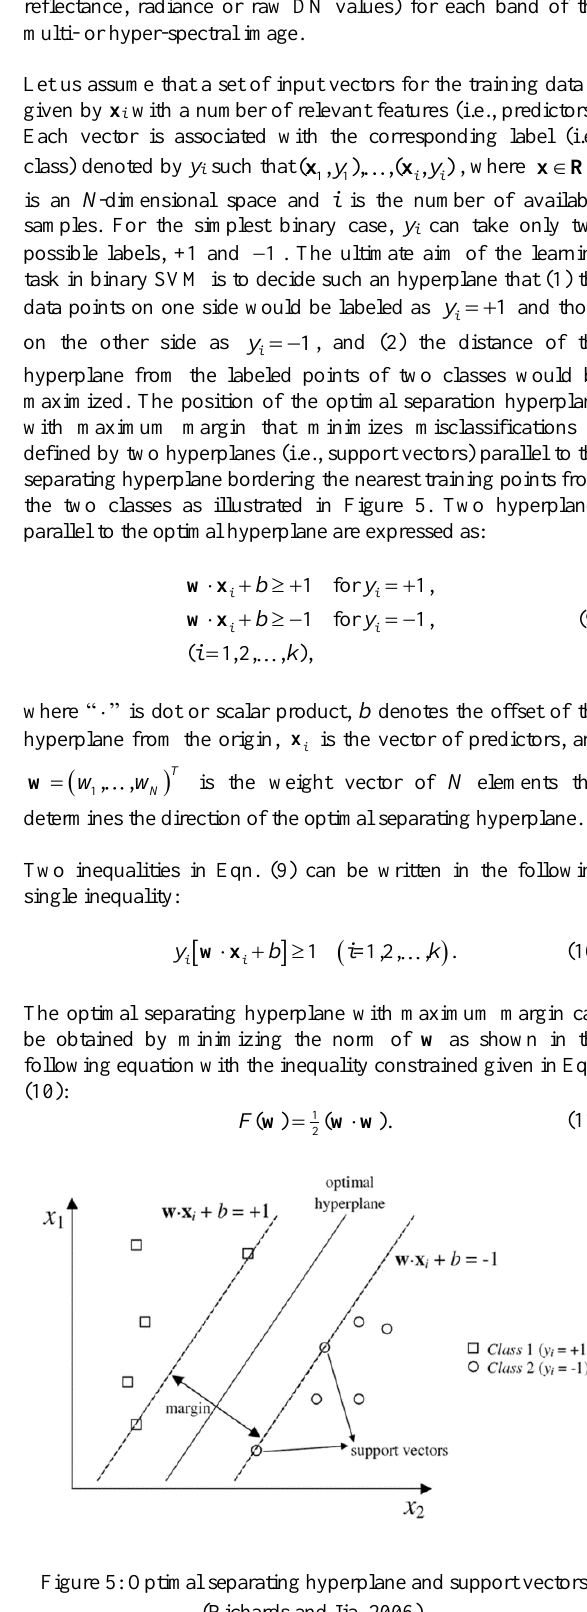
Figure 5: Optimal separating hyperplane and support vectors (Richards and Jia,